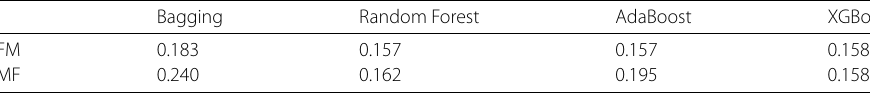
Table 4 Error rates using ensemble learning classification methods Bagging Random Forest